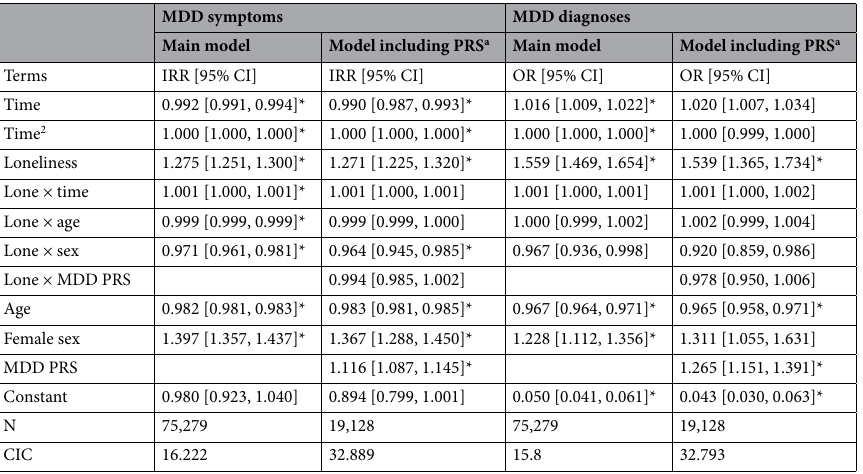
Table 2. Table of GEE models for outcome of MDD symptoms and diagnoses. Displayed are incidence rate ratios (IRR) and odds ratios (OR) with 95% confidence intervals for the different terms in the GEE models. Asterisks indicate statistical significance at Bonferroni-corrected α = 0.00125. All models include a linear and squared time term, a main loneliness effect and a loneliness-time interaction. Furthermore, terms for age and female sex are included both as main effect and a loneliness interaction term. The models in genotyped samples also include an MDD polygenic risk score both as main effect and as a loneliness interaction. N refers to the number of individuals included in the dataset. The correlated information criterion (CIC) is a measure of fit for GEE models. a In sample with genotype data available. Models include the first 10 principle components of the genotype data as covariates as well (not shown).